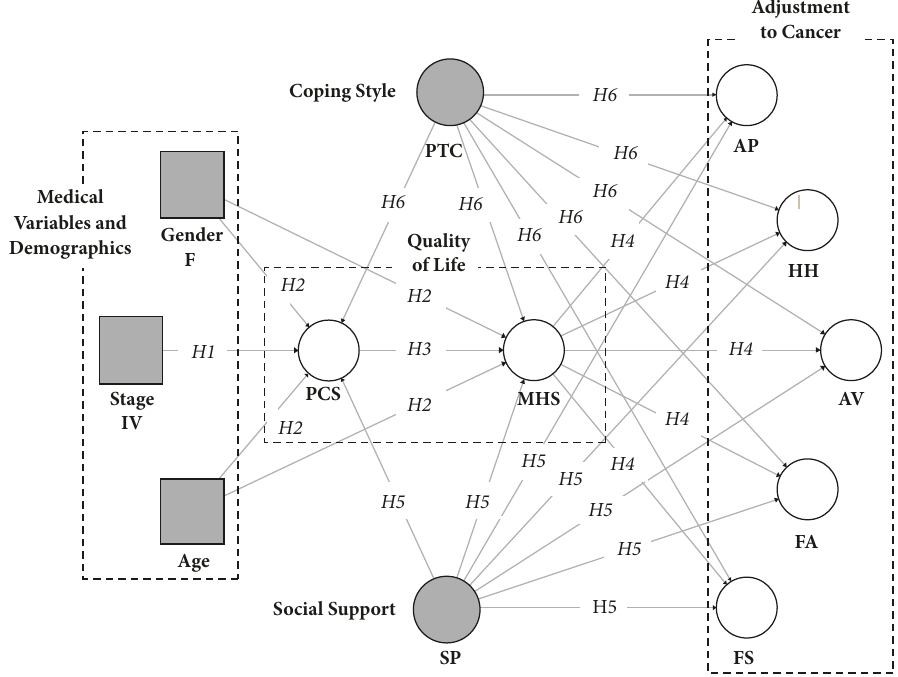
Figure 1: Theoretical model and hypotheses. Legend : Age = patient’s age. Gender F = female versus male gender. Stage IV = Stage IV versus Stage I-III. PCS = Patient’s Physical Functioning. MHS = Patient’s Mental Health. AP = anxious preoccupation. AV = Cognitive Avoidance. FA = Fatalism. FS = Fighting Spirit. HH = Helplessness-Hopelessness. PTC = Positive Thinking Coping Style. SP = Social